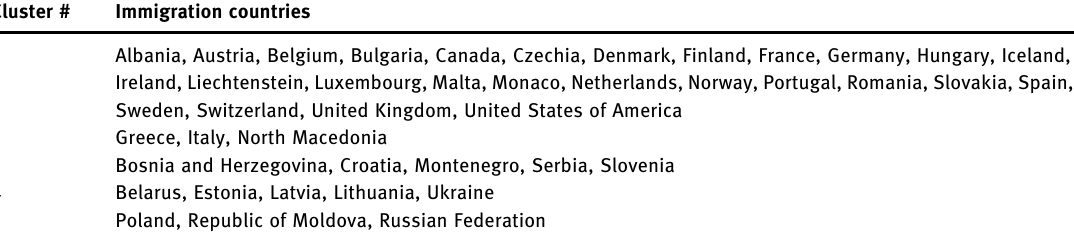
Table 2: Country memberships of immigration trait clusters, 2015 Cluster